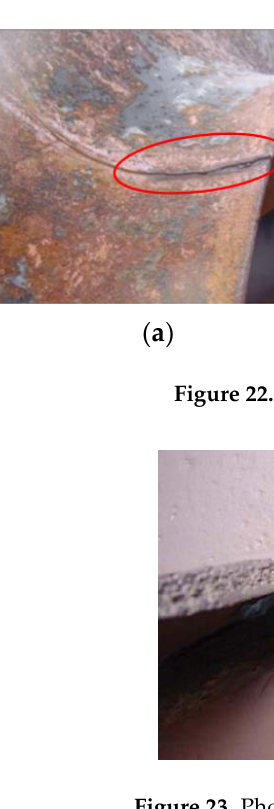
Figure 24. Finite element model of an impeller and a sector model.